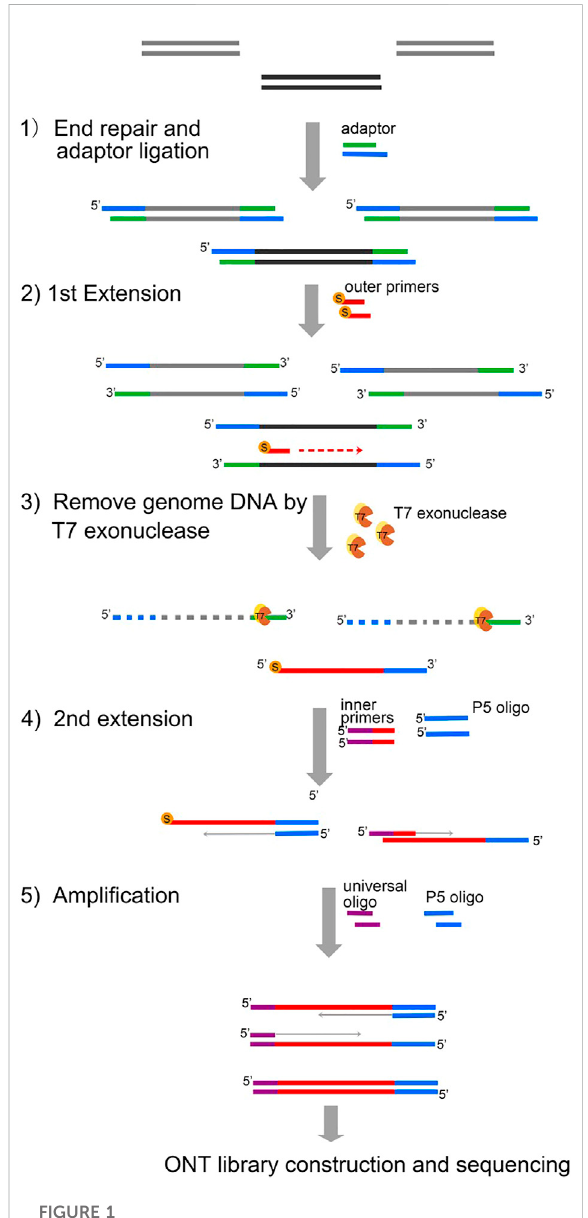
FIGURE 1 Principle of RSA. 1) During the fi rst step of RSA, the genomic template DNA (gray) performed end repair and adaptor ligation using a DNA Library Kit for Illumina. 2) First extension by the